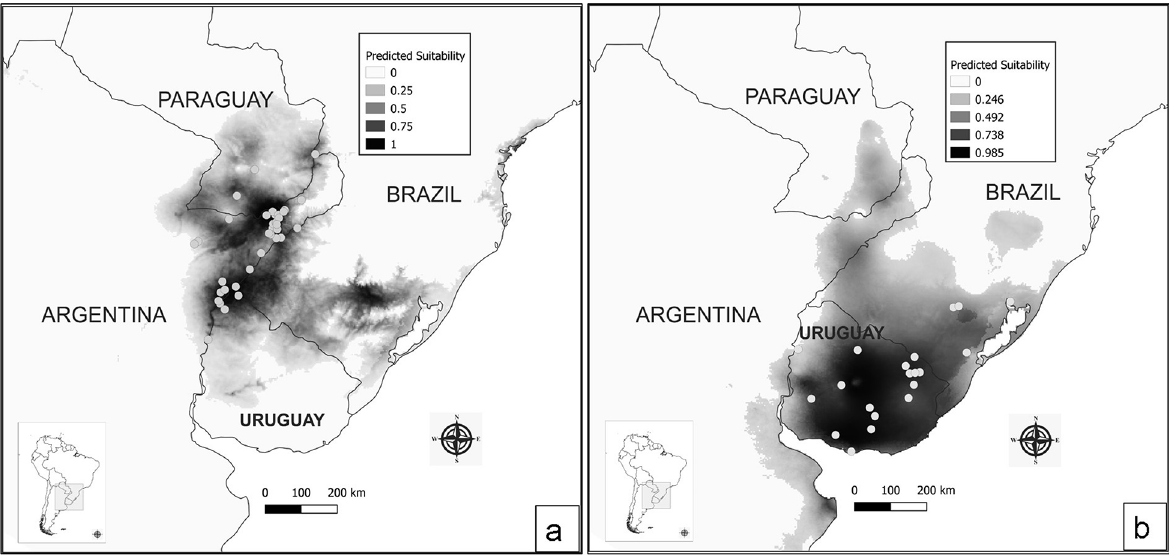
Figure 3. Potential geographic distributions of the Turnera sidoides subsp. carnea morphotypes based upon maximum entropy niche models using current environmental data and point occurrences. Dots represent the occurrence of mercedeño (a) and grandense (b)